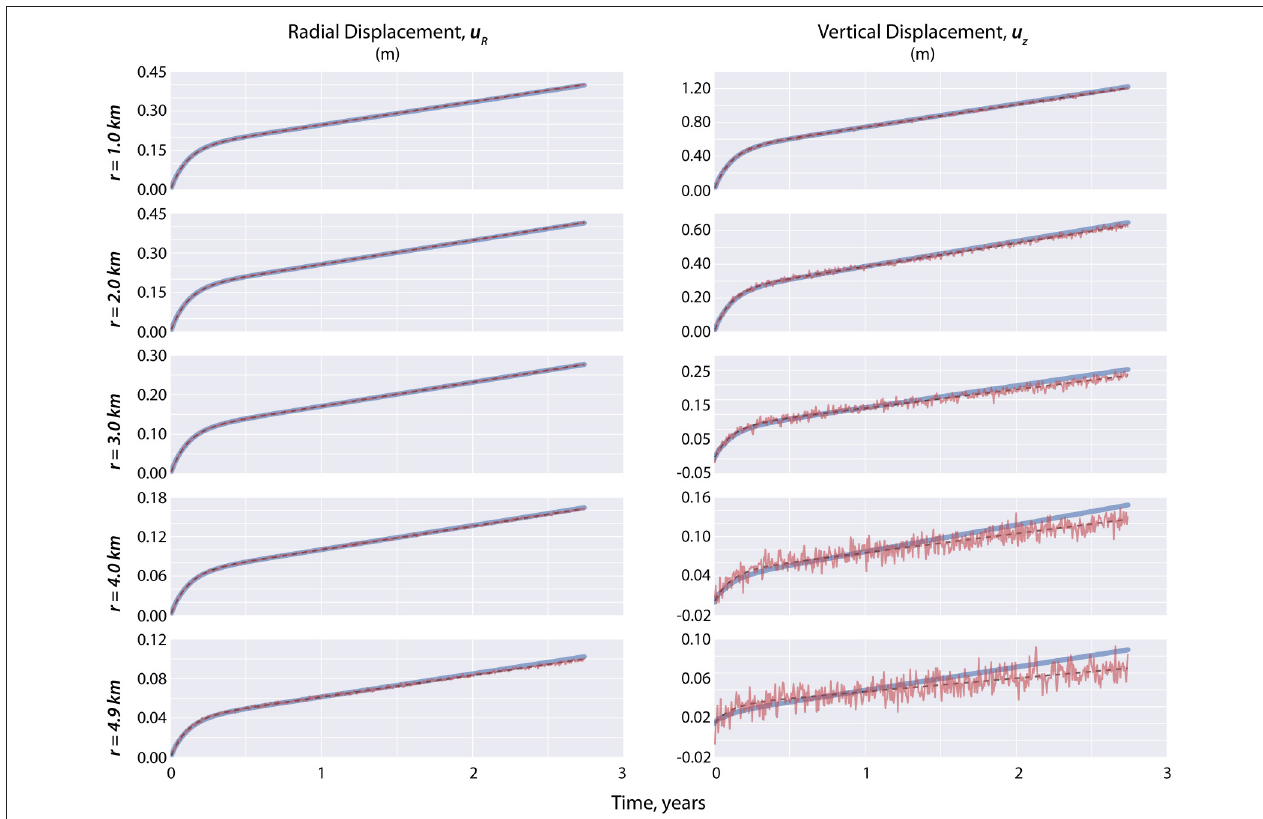
FIGURE 6 | The EnKF-estimated displacements after performing assimilation via state estimation (i.e., blue solid line) given that the prior distribution of the uncertain parameters are far from their true values ( Figure 5C ). The synthetic displacements used as D during the assimilation are the noisy red lines that are more evident in the vertical component at far-field distances. The black broken lines correspond to the true